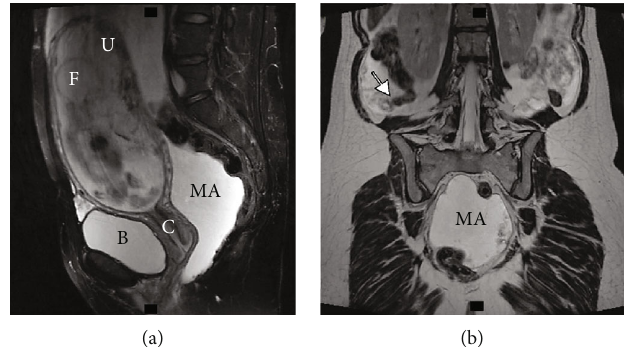
Figure 1: (a) Abdominal and pelvic MRI (sagittal plane) without IV contrast shows a gravid uterus and a substantial amount of T2 hyperintense fl uid. (b) Abdominal and pelvic MRI (coronal plane) without IV contrast demonstrates an enlarged perforated appendix with extraluminal mucin (arrow) and T2 hyperintense fl uid collection in the pelvis. B: bladder; C: cervix; F: fetus; IV: intravenous; MA: mucinous ascites; MRI: magnetic resonance imaging; U: uterus.